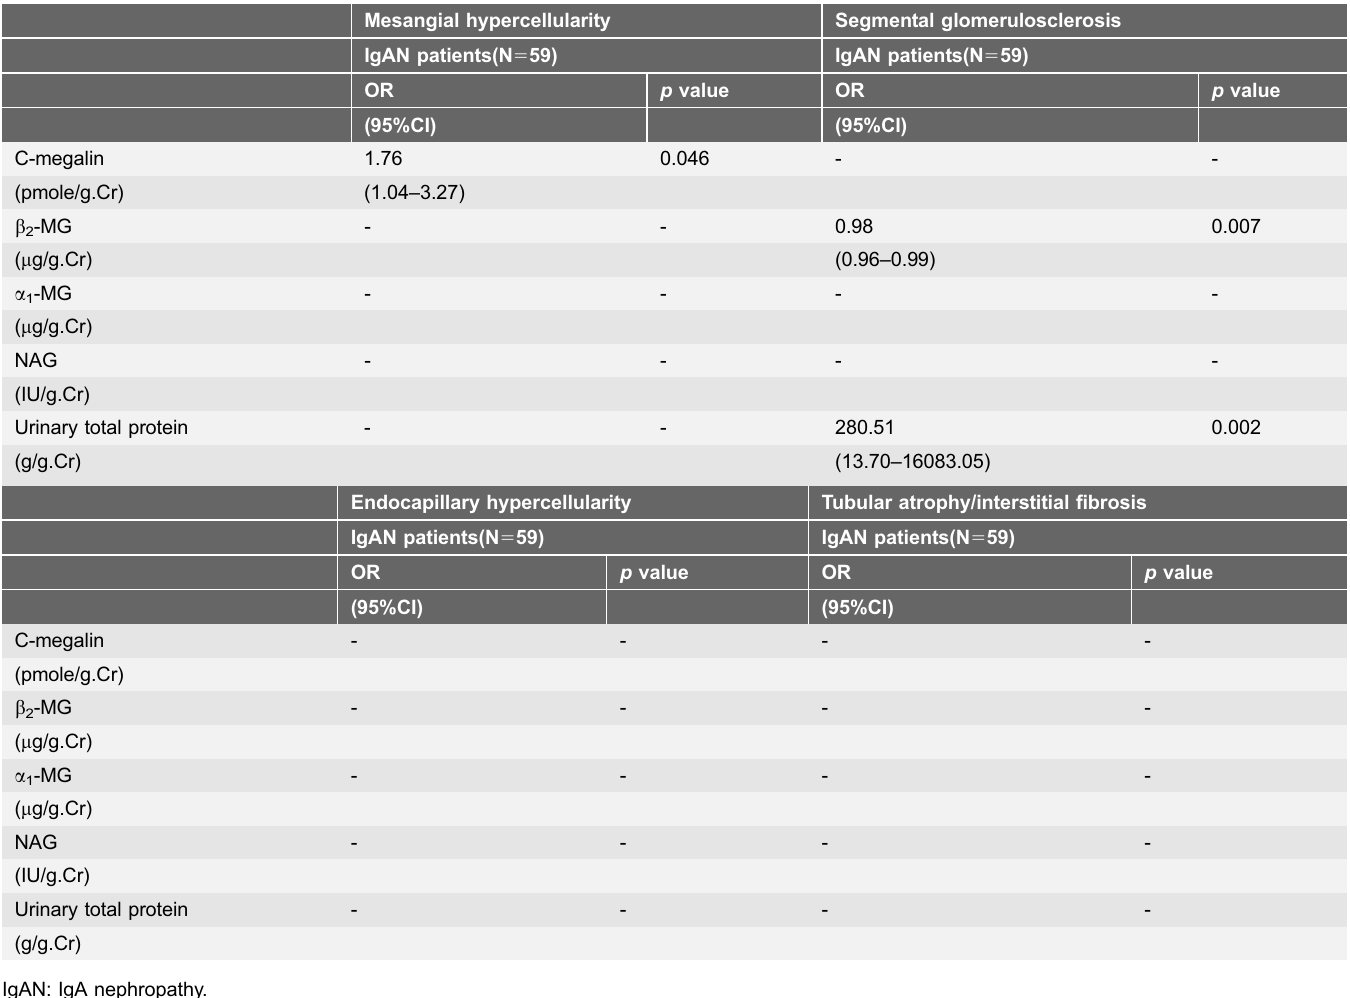
Table 3. Stepwise multiple regression analysis of histological variables in the Oxford classification with relevant